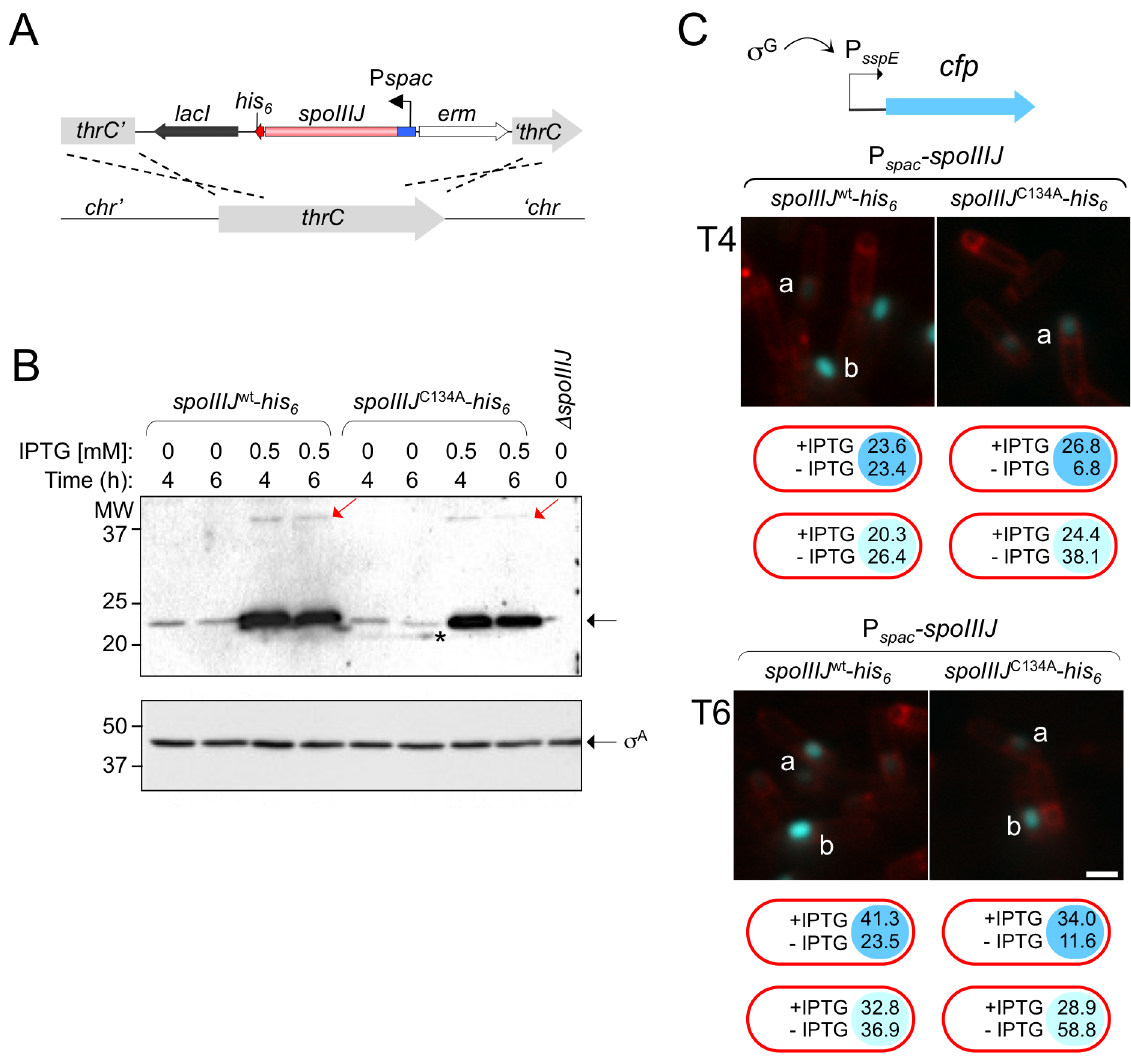
Figure 4. Effect of spoIIIJ C134A on sporulation. (A) Schematic representation of the double crossover integration of a P spac -spoIIIJ-his 6 fusion at the non-essential thrC locus. (B) Strains expressing SpoIIIJ-His 6 or SpoIIIJ C134A -His 6 from P spac at thrC (as shown in A) in a D spoIIIJ background, were grown in parallel with a D spoIIIJ mutant (last lane) in liquid DSM with or without IPTG as indicated and samples withdrawn at hours 4 and 6 of sporulation. Proteins in whole-cell extracts were subject to immunoblot analysis with an anti-His 6 (upper panel) or an anti- s A antibody (lower panel). The samples were resolved by SDS-PAGE under reducing conditions. The position of SpoIIIJ-His 6 , SpoIIIJ C134A -His 6 or s A is indicated by black arrows. The red arrows show the position of presumed SpoIIIJ-His 6 or SpoIIIJ C134A -His 6 dimers. The asterisk indicates a non-specific cross-reacting species. The position of molecular weight markers (in kDa) is shown. (C) Expression of a P sspE - cfp fusion, used as a reporter for s G activity, in DSM cultures of strains expressing wild-type spoIIIJ or the spoIIIJ C134A allele from the P spac promoter at thrC in a D spoIIIJ background. The strains were grown in the absence or in the presence of IPTG (0.5 mM). Only images for the non-induced strains are shown. Samples were collected at the indicated times (in hours) after the onset of sporulation, stained with the membrane dye FM4-64 and observed by fluorescence microscopy. CFP and FM4-64 fluorescence are shown in blue and red, respectively. The fluorescence patterns were designated by low (class a ) or high (class b ) fluorescence. Scale bar, 1 m m. The cartoons below each panel show the percentage of cells in class a (light blue) or class b (darker blue) for each of the indicated strains grown in the absence (‘‘ 2 ’’) or in the presence (‘‘ + ’’) of 0.5 mM IPTG, as indicated. At least 200 cells were scored for each of the a or b classes (see the Material and Methods